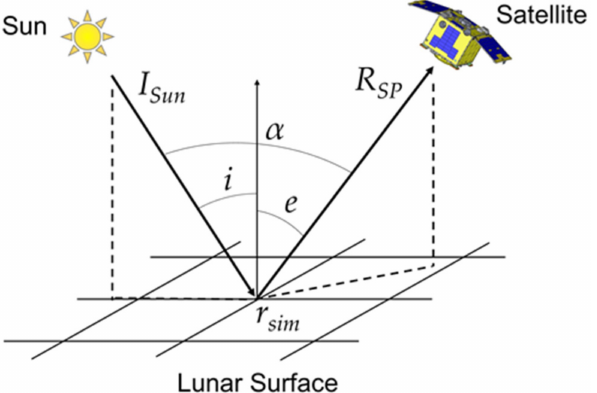
Figure 3. Definition of the solar incident angle ( i ), emission angle ( e ), and phase angle ( α ) used for the simulation of the lunar surface radiance ( R SP ) calculated from the solar irradiance ( I Sun ) and the radiance factor ( r sim ) in the Spectrum Profiler (SP) model.